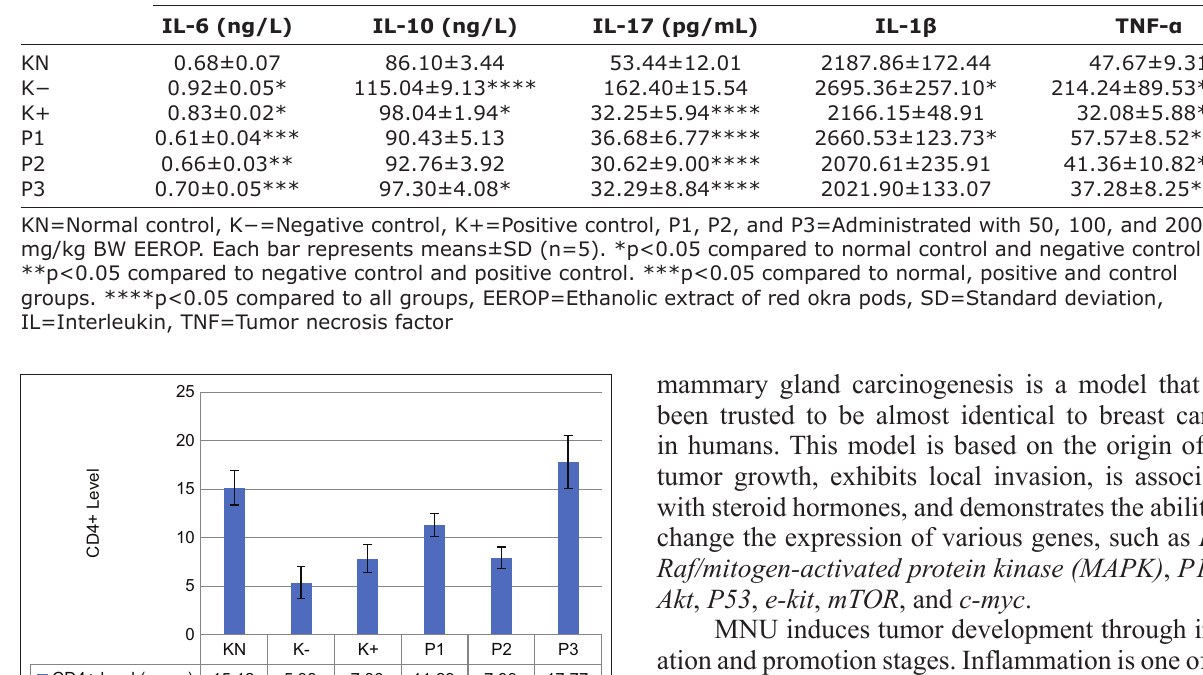
Table-1: Effect of ethanolic extract of red okra pods on the level of cytokines.